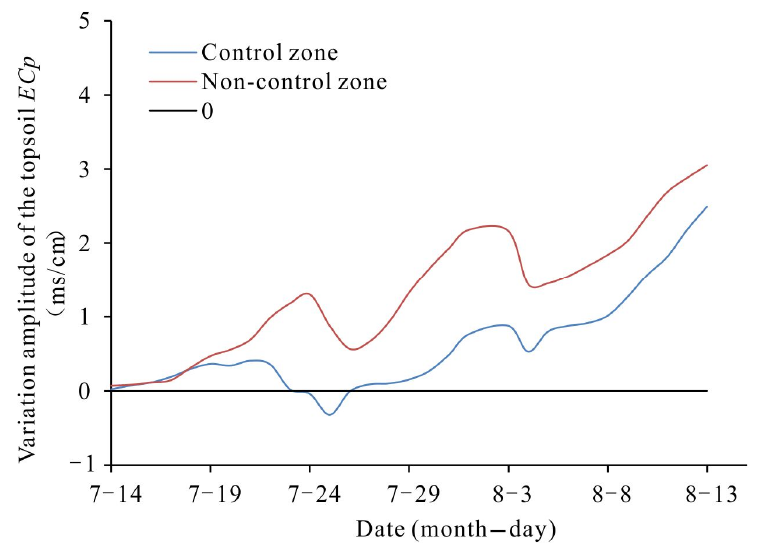
Figure 10. Increased amplitude of the EC p of the topsoil in the control and non-control zones.